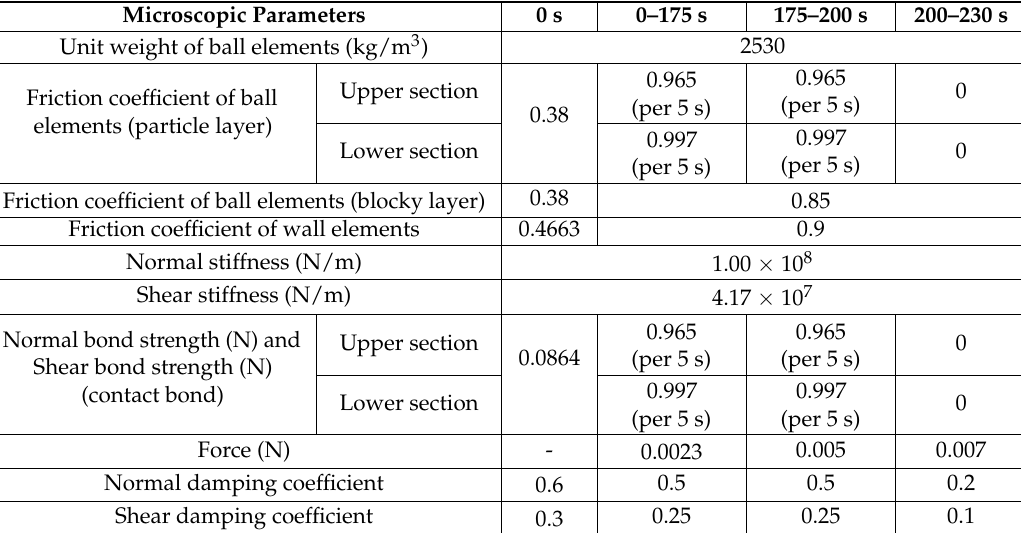
Table 2. Microscopic parameters of the digital